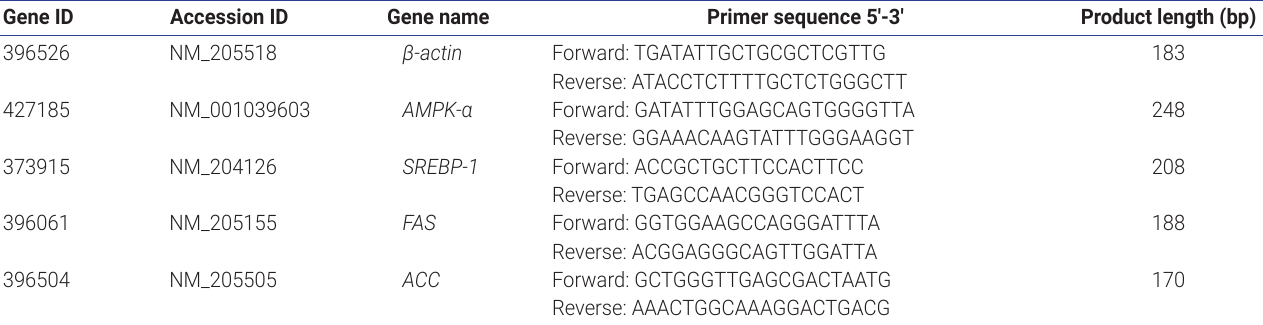
Table 2. Primer sequences used for real-time polymerase chain